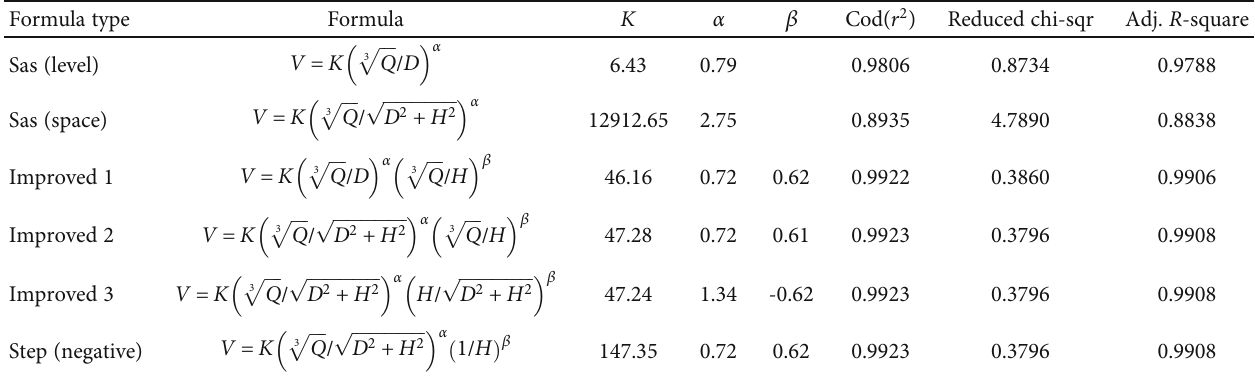
Figure 6: Monitoring data on October 16. Table 2: Test data regression